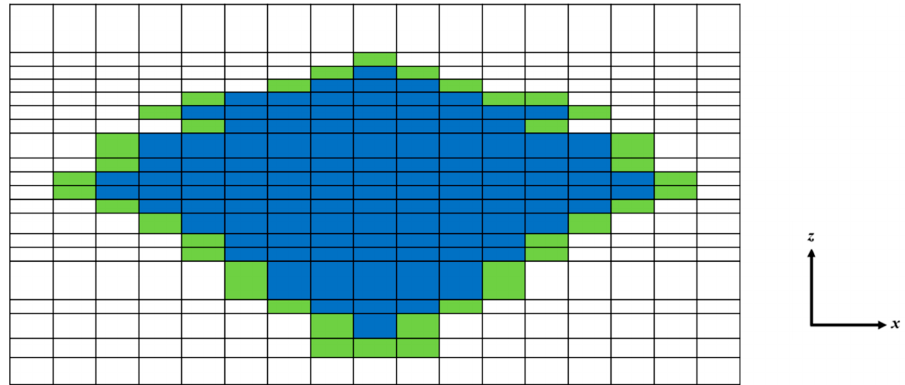
Figure 4. Conceptual model of fracture on the grid in FracCSM. Green grid blocks refer to newly activated (cracked) grid blocks on the edge of the fracture at the current time step. Blue grid blocks refer to grid blocks that were cracked in previous time steps, while grid blocks refer to intact rocks.